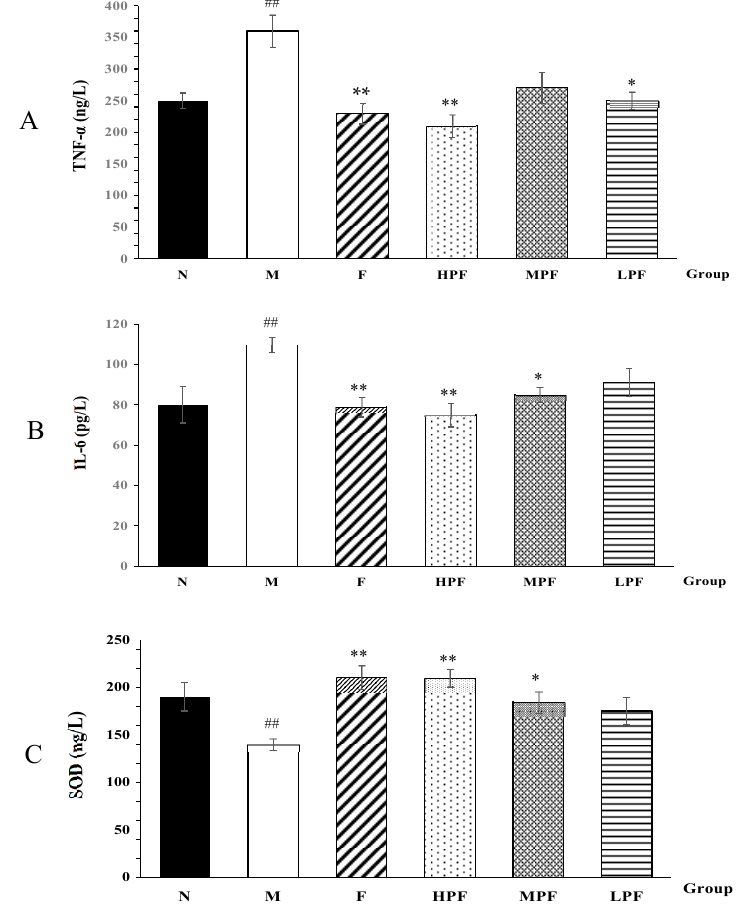
Figure 4. Effects of PF on TNF- α ( A ), IL-6 ( B ) and SOD ( C ) activity (compared with normal control group, ## p < 0.01; compared with the LPS-induced model group, * p < 0.05, ** p < 0.01).